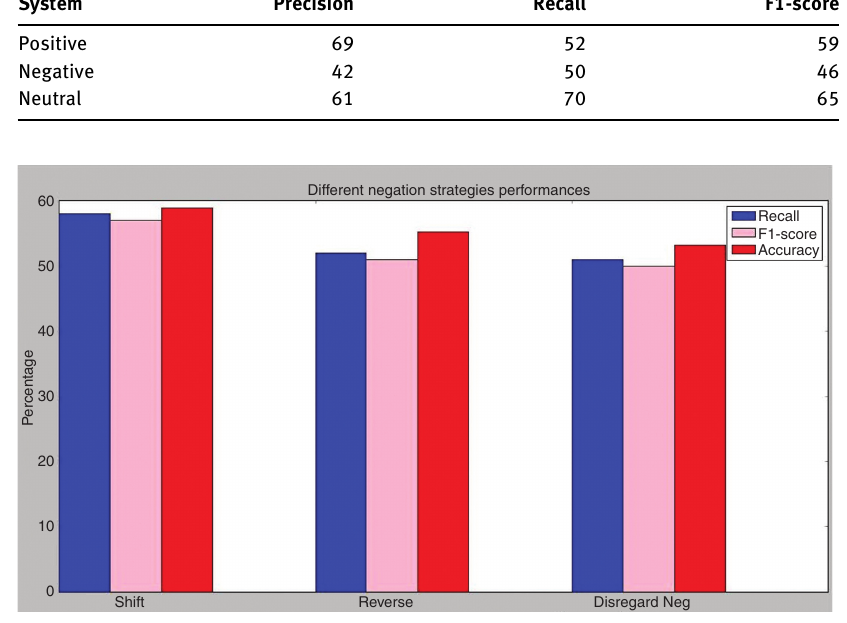
Figure 2: Comparison of Different Negation Strategies.